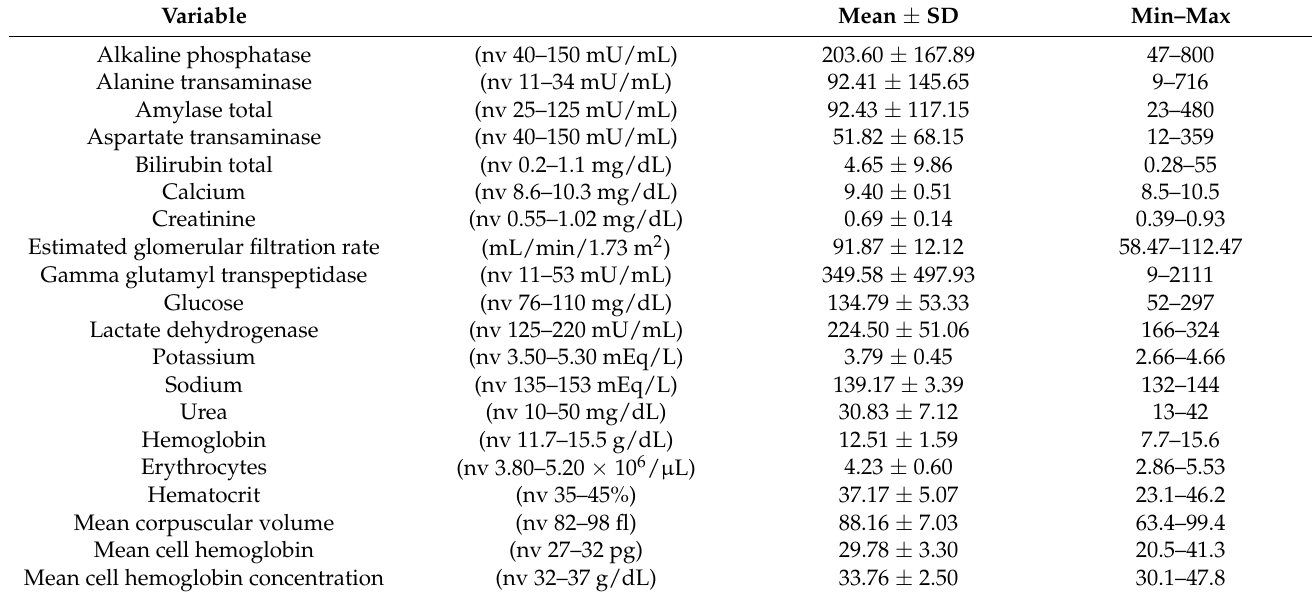
Table 2. Patient biohumoral variables and number of chemotherapy cycles tolerated